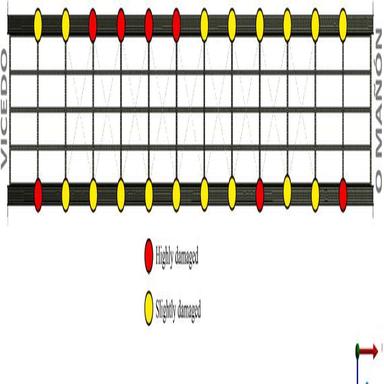
Scheme of the damaged condition state of the steel connections.